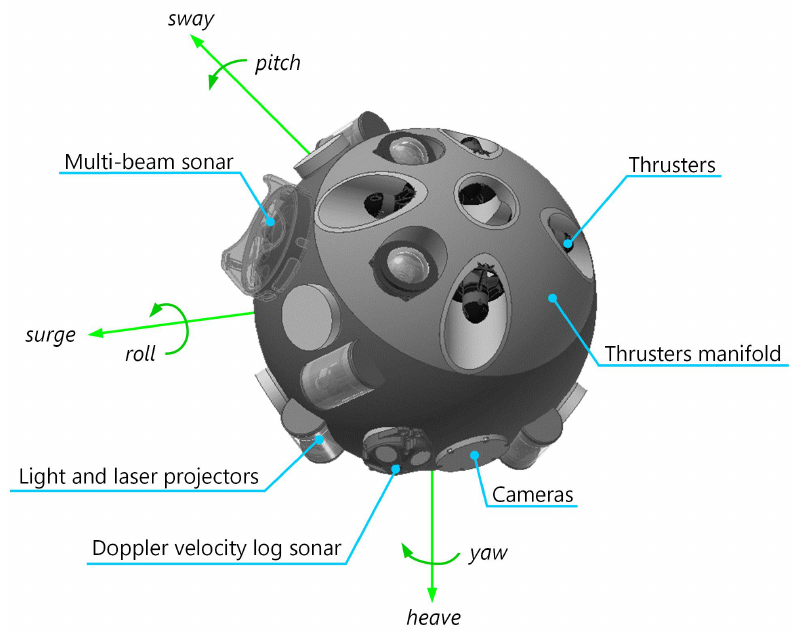
Figure 3. In blue, main components of the UX-1 robot for navigation; in green, description of motion coordinates according to Society of Naval Architects and Marine Engineers (SNAME).